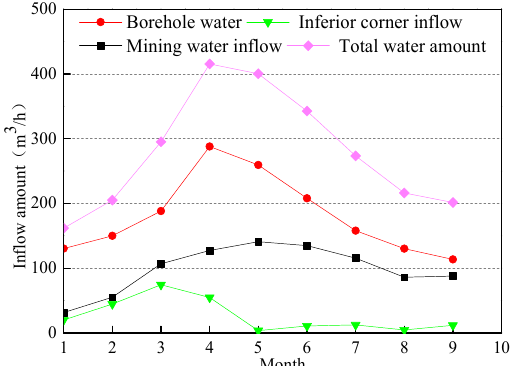
Figure 15. The composition of monthly average inrush water of working face 112208.